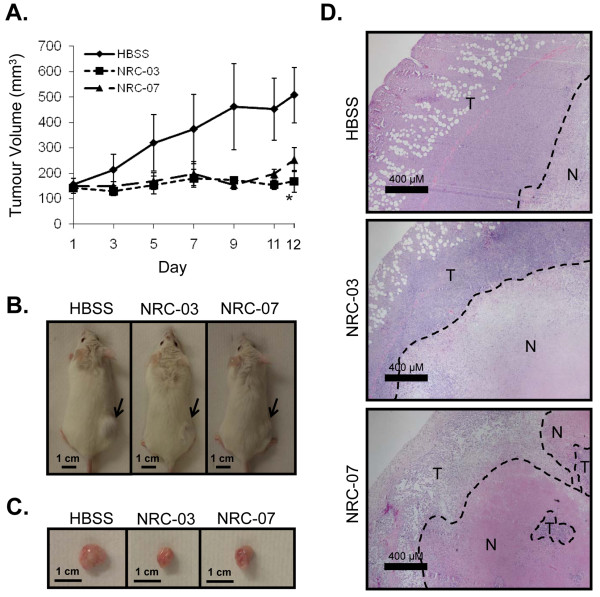
NRC-03 and NRC-07 halt the growth of breast cancer xenografts in mice. MDA-MB-231 breast cancer cells were implanted in the right hind flank of NOD SCID mice. Once tumors reached a volume at least 120 mm3, they were injected with the HBSS alone or with 0.5 mg NRC-03 or NRC-07 (in HBSS) on days 1, 3, and 5. (a) Tumor volume was determined on days 1, 3, 5, 7, 9, 11, and 12 after the start of peptide treatment. Data shown are the mean tumor volume ± SEM from three independent experiments (three mice per group conducted three times for a total of nine mice per treatment). Statistical significance was determined with the Bonferroni multiple comparisons test; *p < 0.05 compared with HBSS-treated animals. (b) On day 12, mice were killed and photographed, and (c) the tumors were excised and photographed (d). Tumor sections were stained with hematoxylin and eosin, and photographed by using bright-field microscopy (×400). Scale bars indicate 400 μm. T, viable cells; N, necrotic cells. Representative images are shown.